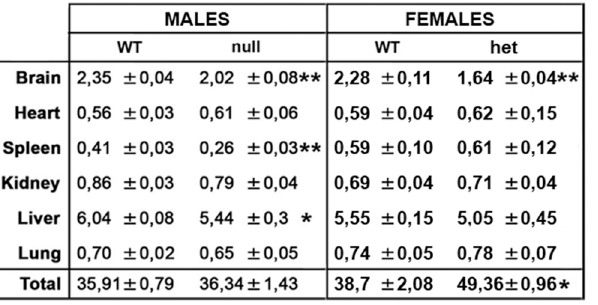
displayed a reduced brain size and an increase in overall size at the time of sacrifice (the weight of the organs is represented as percentage of the total body weight of each animal). Statistical significance was evaluated through Student ’ s t-test; * = p < 0,05; ** = p < 0,01; n = 12 wt males, 10 null, 8 Mecp2 +/- and 9 wt females.